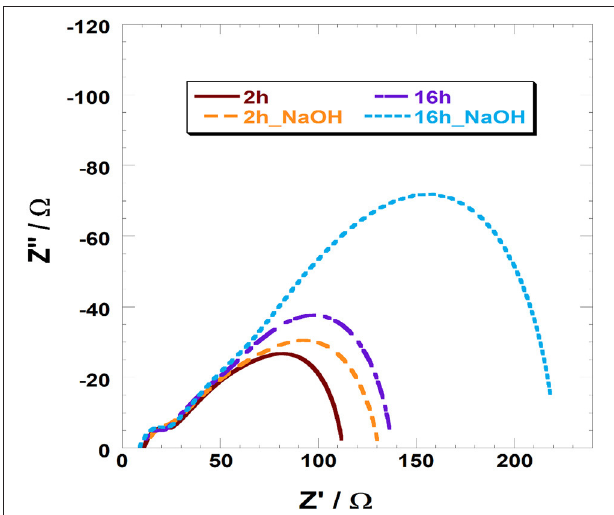
FIGURE 5 | EIS analysis of VG21-C12 based devices.